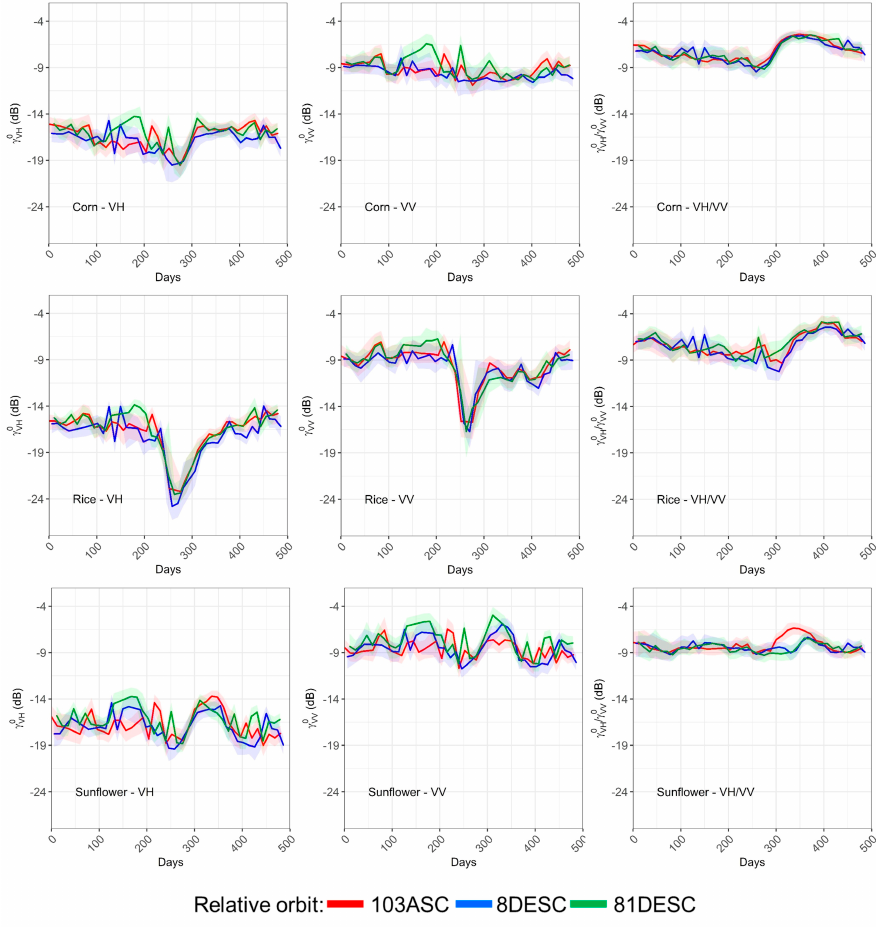
Figure 7. Median temporal signatures of main summer crops (corn, rice and sunflower) for VH, VV and VH/VV in Navarre. The three relative orbits are represented in different colors (see the legend). The interquartile range is represented for all the different time series as a colored shadow. The horizontal axes represent the period of study, from 1 September 2015 (day 0) to 30 December 2016 (day 487).